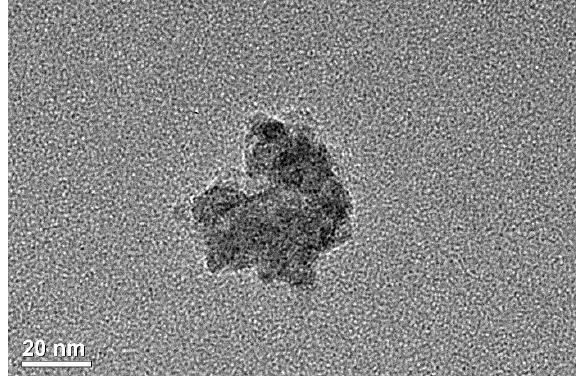
Figure 1. TEM image of a graphite nanoparticle.